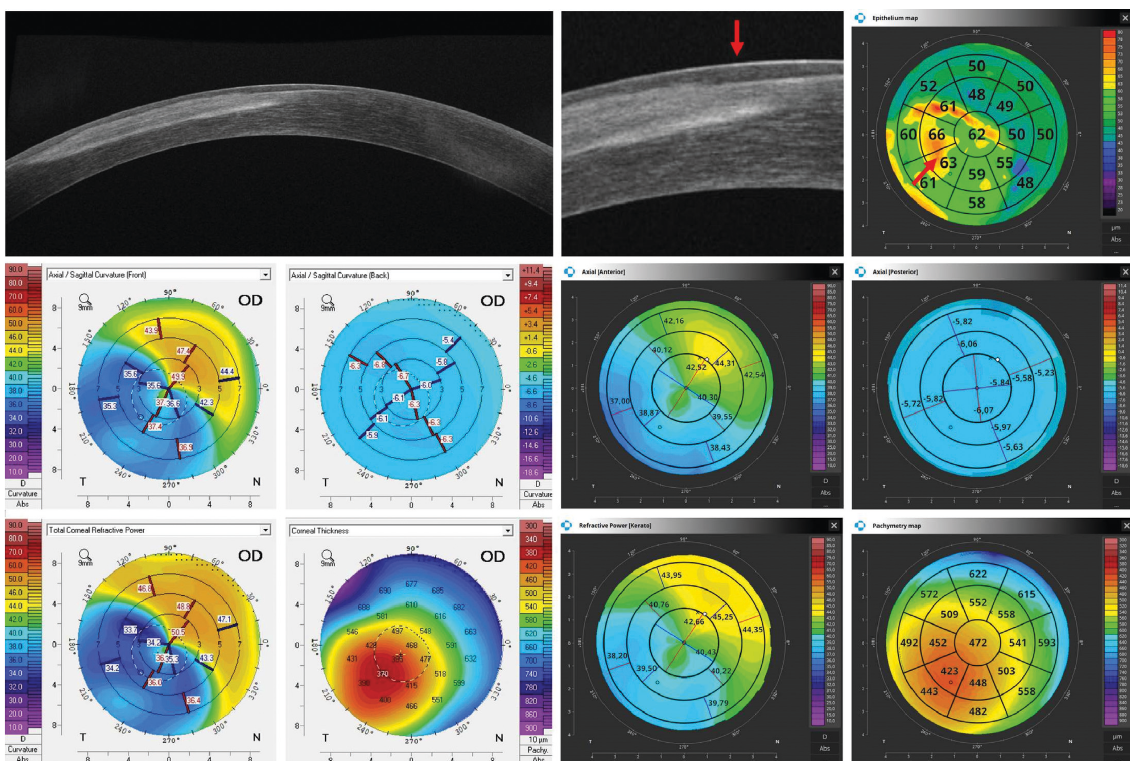
Figure 3: Ulcerative keratitis with extensive corneal stromal scarring. ETM shows thickening of the epithelium in the area of the disease process (red arrow). Topography maps depict irregular astigmatism of the anterior surface of the cornea while the posterior surface is regular. The measurements performed with Pentacam have a white background, and the ones performed with the REVO NX have a black background. The K1, K2, and astigmatism values for the anterior surface of the cornea obtained using Pentacam are 36.8D, 42.9D, and 6.1D, respectively, while the values obtained using REVO NX are 37.6D, 42.9D, and 5.3D, respectively. The values of analogous parameters for the posterior corneal surface from Pentacam are − 6.0 D, − 6.3D, and 0.3 D and the values from the REVO NX are − 5.8D, − 6.0D, and